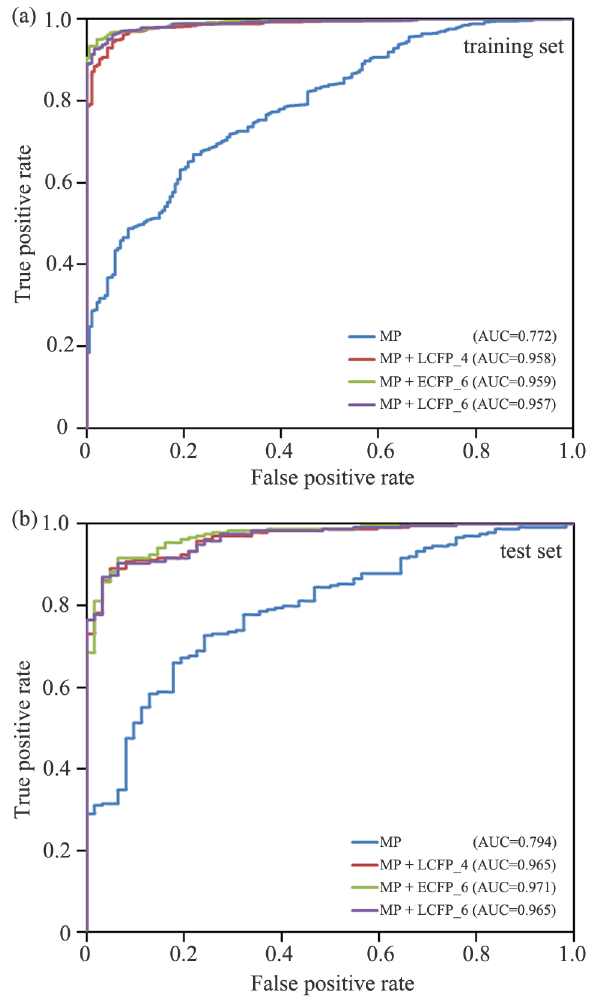
Figure 6. The performance of different models depicted graphically via receiver operating characteristic (ROC) plot of Bayesian model based on molecular properties (MP) and fingerprints for (a) training set and (b) for test set.